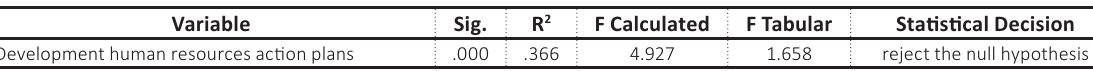
Table 9. Simple linear regression test for H3 Variable Sig. Table 10. Simple linear regression test for H4 Variable